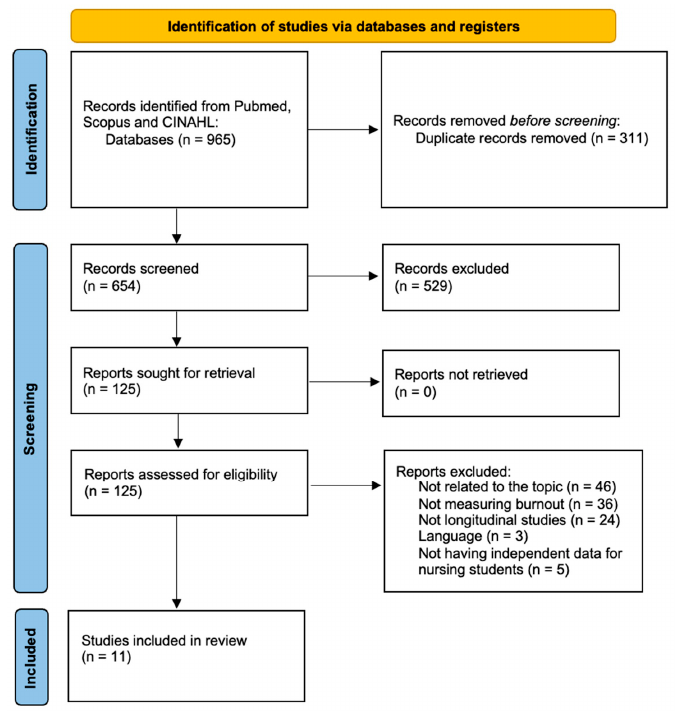
Figure 1. Flow diagram of study selection process.